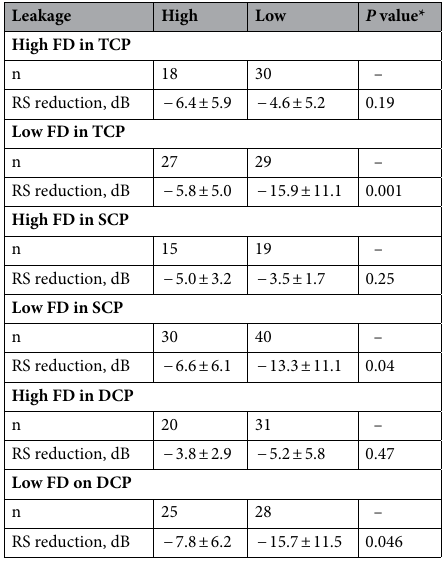
Table 5. Comparison of retinal sensitivity at each flow density between the high and low leakage groups with low retinal thickness (≤ 261 μm). *Wilcoxon rank-sum test. DCP deep capillary plexus layer, FD flow